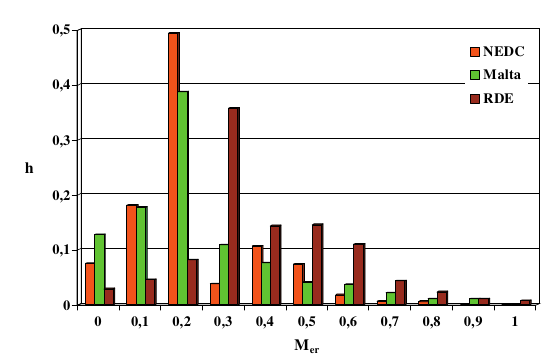
Fig. 20. Histogram of relative engine power in the NEDC, Malta and RDE tests The process value results also confirmed the conclu- sions drawn from the assessment of the average value and the coefficient of variation. For rotational speed, the differ- ences in histograms for individual tests are not significant, while for the relative torque and relative engine power much higher relative values were found in the RDE test with the increased occurrence of states with high values compared to the other